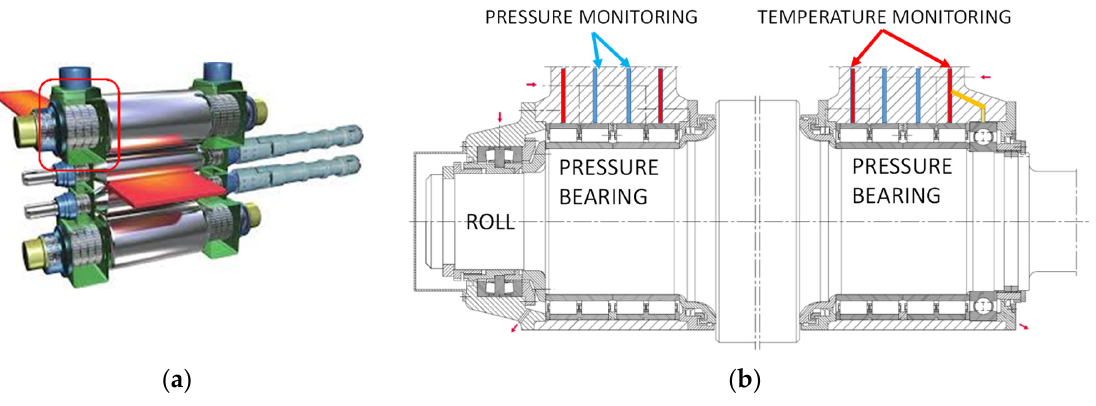
Figure 6. Example of location of sensors for pressure and temperature measurement upon back bearings of a hot rolling mill drawn upon rendering of bearing ( a ) and assembly ( b ).